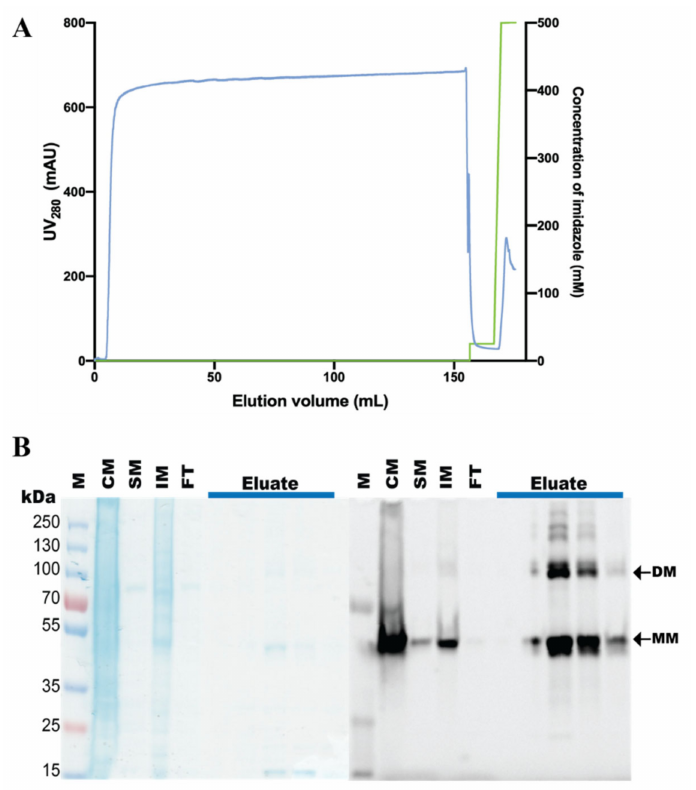
Figure 4. Purification of the hZIP1-TEV-GFP-His fusion. ( A ) Representative purification of hZIP1 C-terminally fused to TEV-GFP-His-tag. Protein was purified from crude Saccharomyces cerevisiae membranes isolated from ≈ 7 g of flask-grown cells and solubilized in 2% ( w / v ) DDM + 0.68% ( w / v ) CHS for 2 h at 4 ◦ C. Profile from immobilized metal affinity chromatography (IMAC) indicates UV 280 signal for protein (blue) and concentration of imidazole applied at each step of the affinity purification (green). CHS: cholesteryl hemisuccinate Tris salt. ( B ) Coomassie staining (left) and in-gel GFP fluorescence (right) of the corresponding SDS-PAGE-separated samples collected during IMAC purification. M: marker; CM: crude membranes; SM: solubilized membranes; IM: insoluble material; FT: IMAC flow-through; Eluate: IMAC peak nonconcentrated elution fractions eluted with 500 mM imidazole. Arrows indicate the monomeric (MM) and dimeric (DM) forms of purified hZIP-TEV-GFP-His fusion, with the predicted MWs of the respective fusions of 63.3 kDa (MM) and 126.6 kDa